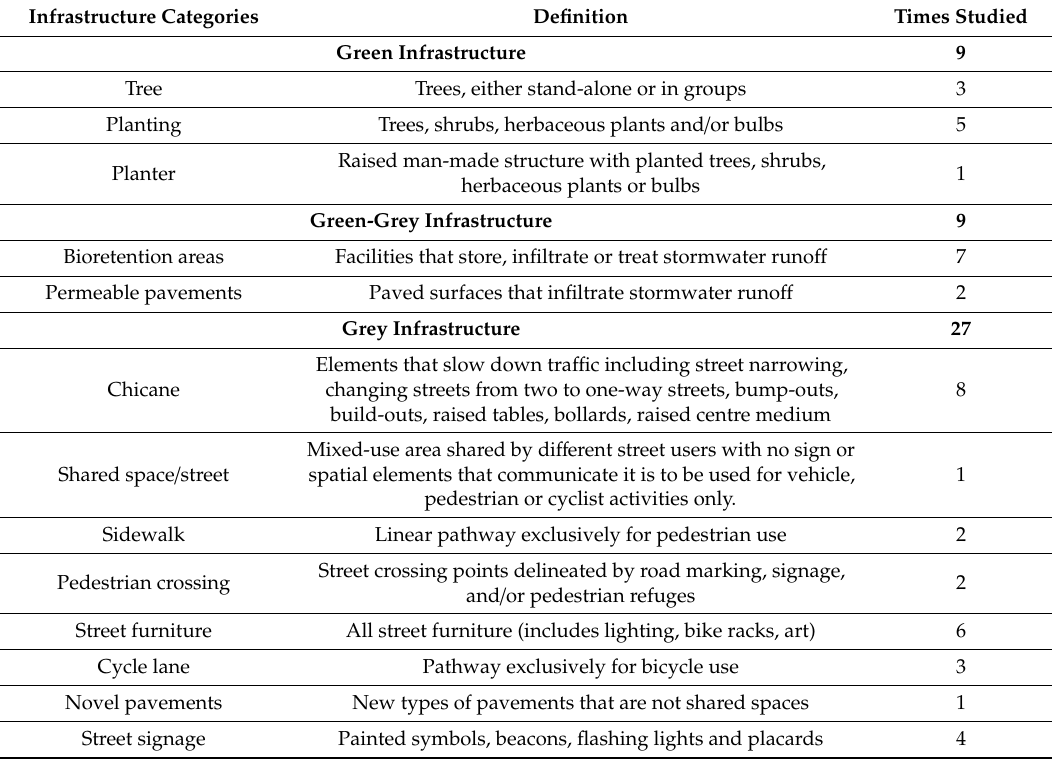
Table A2. Continuum infrastructure element types from green to green-grey to grey.